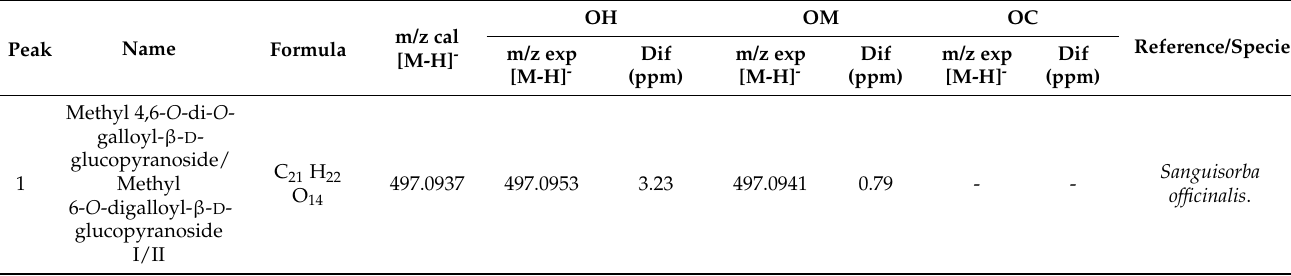
Table 3. Identification of phenolic compounds using liquid chromatography–electrospray quadrupole-time of flight mass spectrometry (LC-ESI-QTOF/MS).